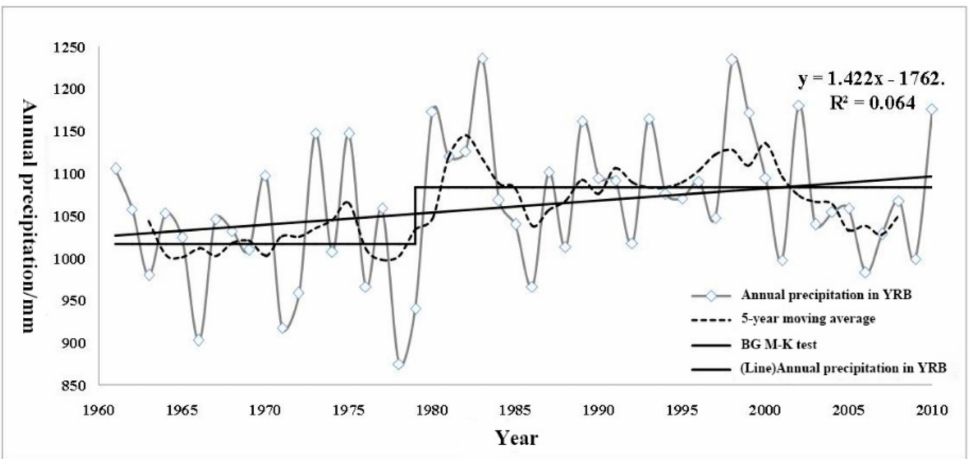
Figure 2. Annual rainfall in the YRB from 1961 to 2010 combined with a five-year moving